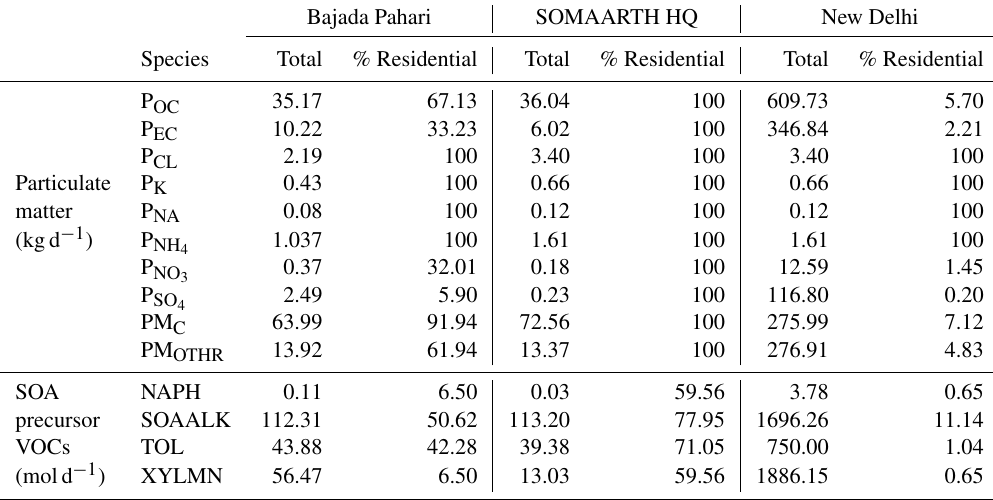
Table 5. Mealtime ∗ particulate matter surface emissions over a corresponding 16km 2 grid cell.